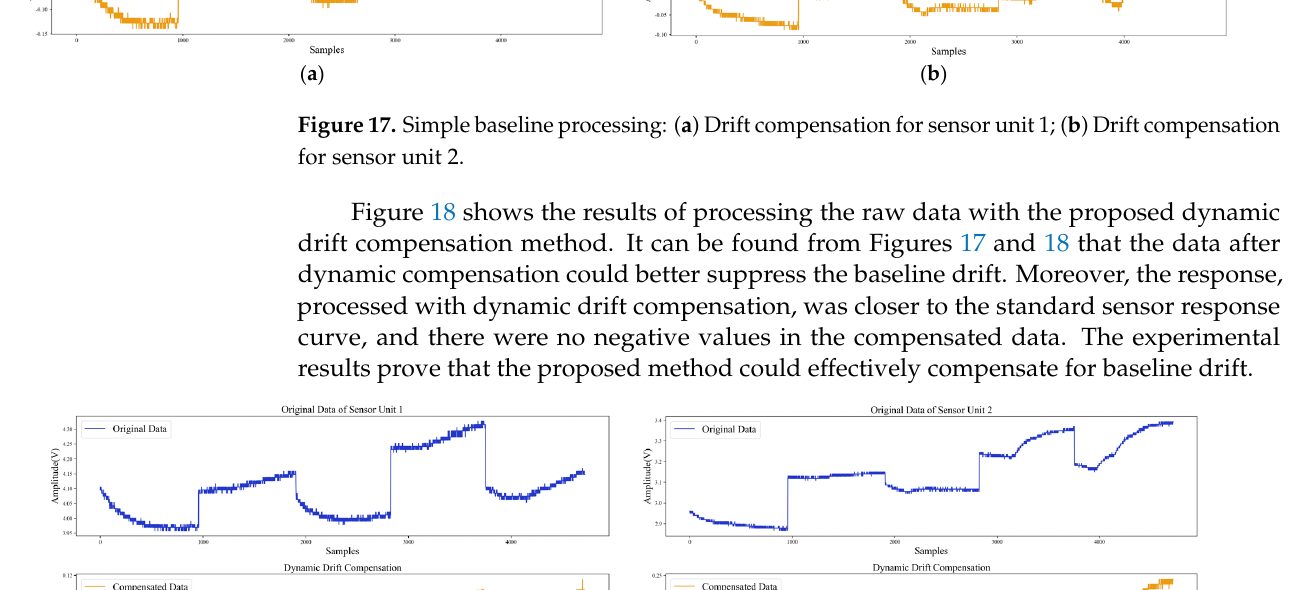
Figure 18. Dynamic drift compensation: ( a ) Drift compensation for sensor unit 1; ( b ) Drift compen- sation for sensor unit 2.